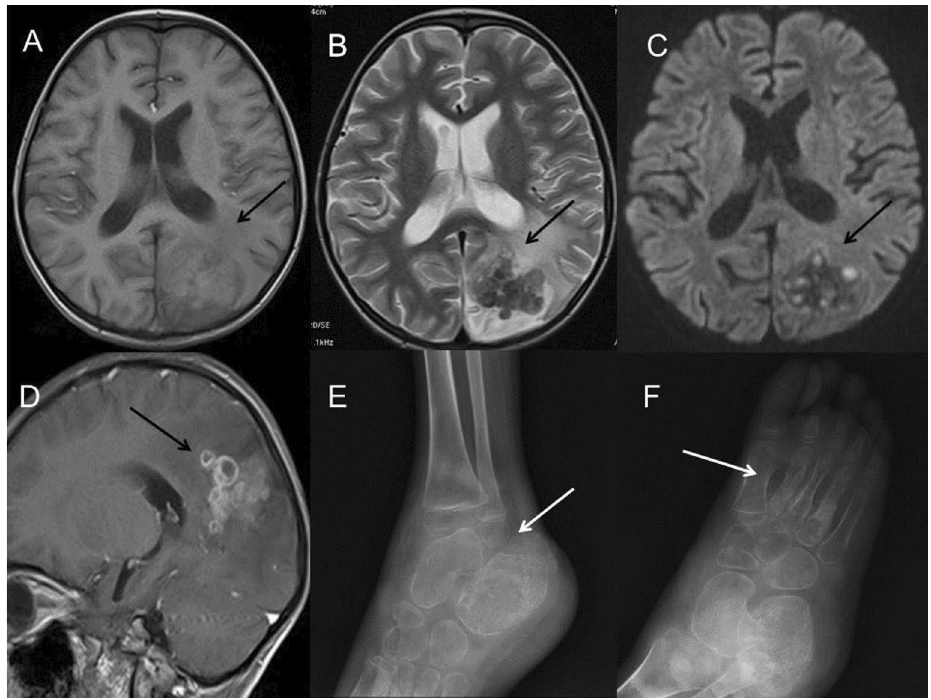
Figure 6. A 5-year-old boy with infection of TB. ( A – D ) MRI showed multiple small cerebral abscesses (long arrow) in the left parietal and occipital lobes, which had high intensity on T1WI ( A ), low intensity on T2WI ( B ), high intensity on DWI sequence ( C ) and annular enhancement on post-contrast T1WI ( D ), suggesting the presence of caseous necrosis. Extensive cerebral edema could be found around the lesions. ( E , F ) Osteomyelitis in the right tibia and foot was found in the same patient, demonstrating local bone erosions and osteosclerosis in the lower metaphysis of the tibia, the calcaneal and the 2nd–4th metatarsal bones (long arrow). Periosteal thickening along the metatarsal bones and swelling soft tissue of the right ankle and foot were